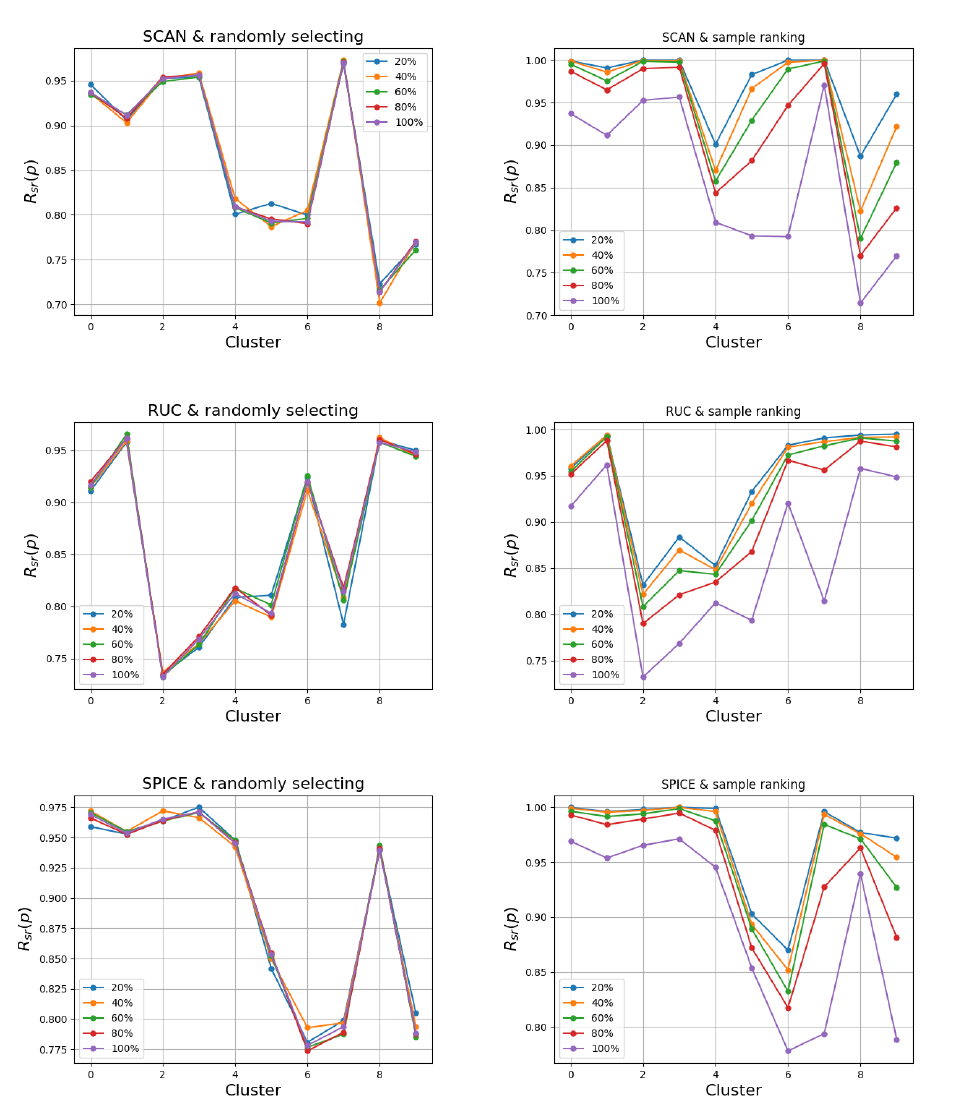
Figure 3. Sample ranking performances of Algorithm 1 (see also Figure 1). First column, R sr ( p ) without applying our ranking algorithm and randomly selecting p = 20%, 40%, · · · , 80% of samples in the clusters formed by 3 pretrained clustering models for CIFAR-10. Second column, after applying our ranking algorithm to rank the samples in the clusters formed by the same 3 pretrained clustering model, R sr ( p ) for p = 20%,40%, · · · ,